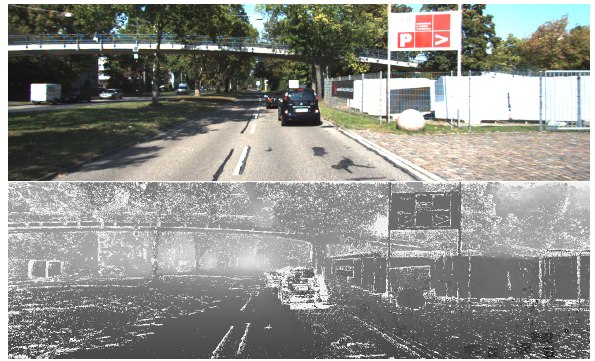
Figure 2. Result of ’low latency’ variant on a frame of sequence 2011_09_26_drive_0013 of the KITTI raw data